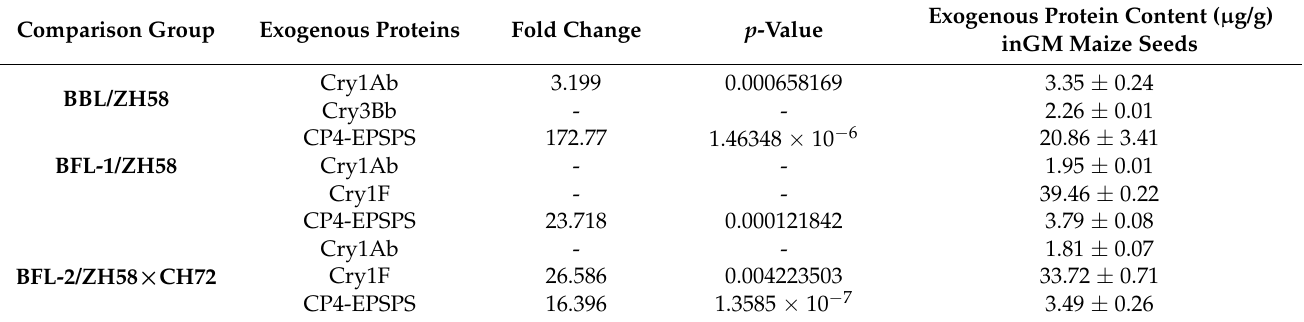
Table 6. Exogenous proteins detected by LFQ proteomics and